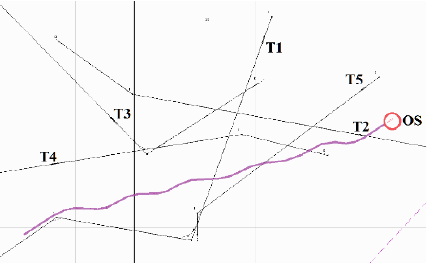
Fig. 9. Trajectory and position of the own ship (OS) and the target ships (T1–T5).